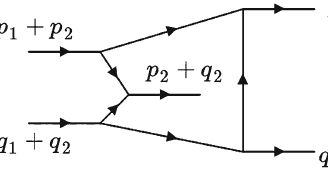
Fig. 8 A five point one-loop diagram